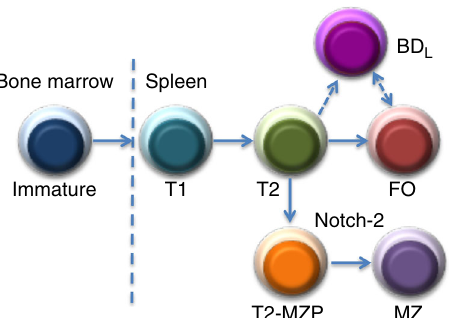
Fig. 10 Revised model of B cell differentiation in the spleen including the BD L subset. Currently, it is thought that immature B cells exit the BM and enter the spleen where they undergo sequential differentiation into T1 then T2, which differentiate into either FO B cells or T2-MZP that upon Notch-2 signaling further differentiate into MZ B cells. BD L are a new mature B cell subset that differentiates directly from the T2 stage. Alternatively, BD